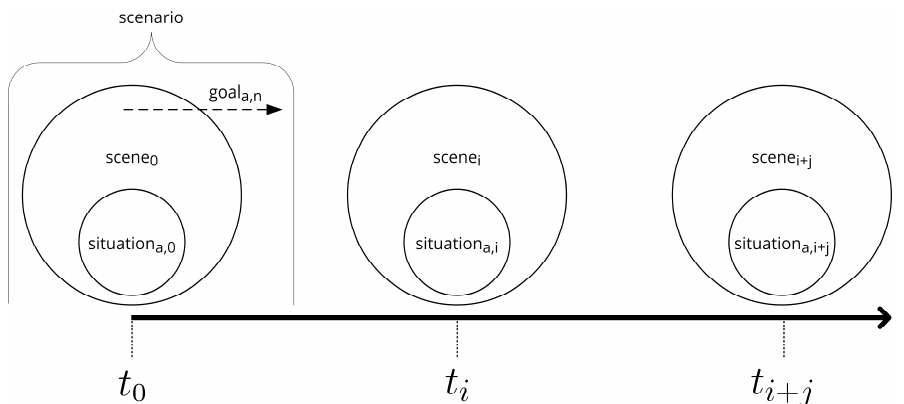
Figure 2. Graphical representation of the relationships between the terms situation, scene, and scenario. The discrete–time axis of the simulation is shown below. t 0 represents the initial state of the simulation. The available information about all actors and their environment can be seen as an individual scene (scene n ) at any point in time t n . For each actor, a situation a,n exists within each scene as a subset of the information it contains. A scenario is comprised of a so-called starting scene combined with the actors’ goals, values, and functions f ( t ) , which influence the progression over time of the